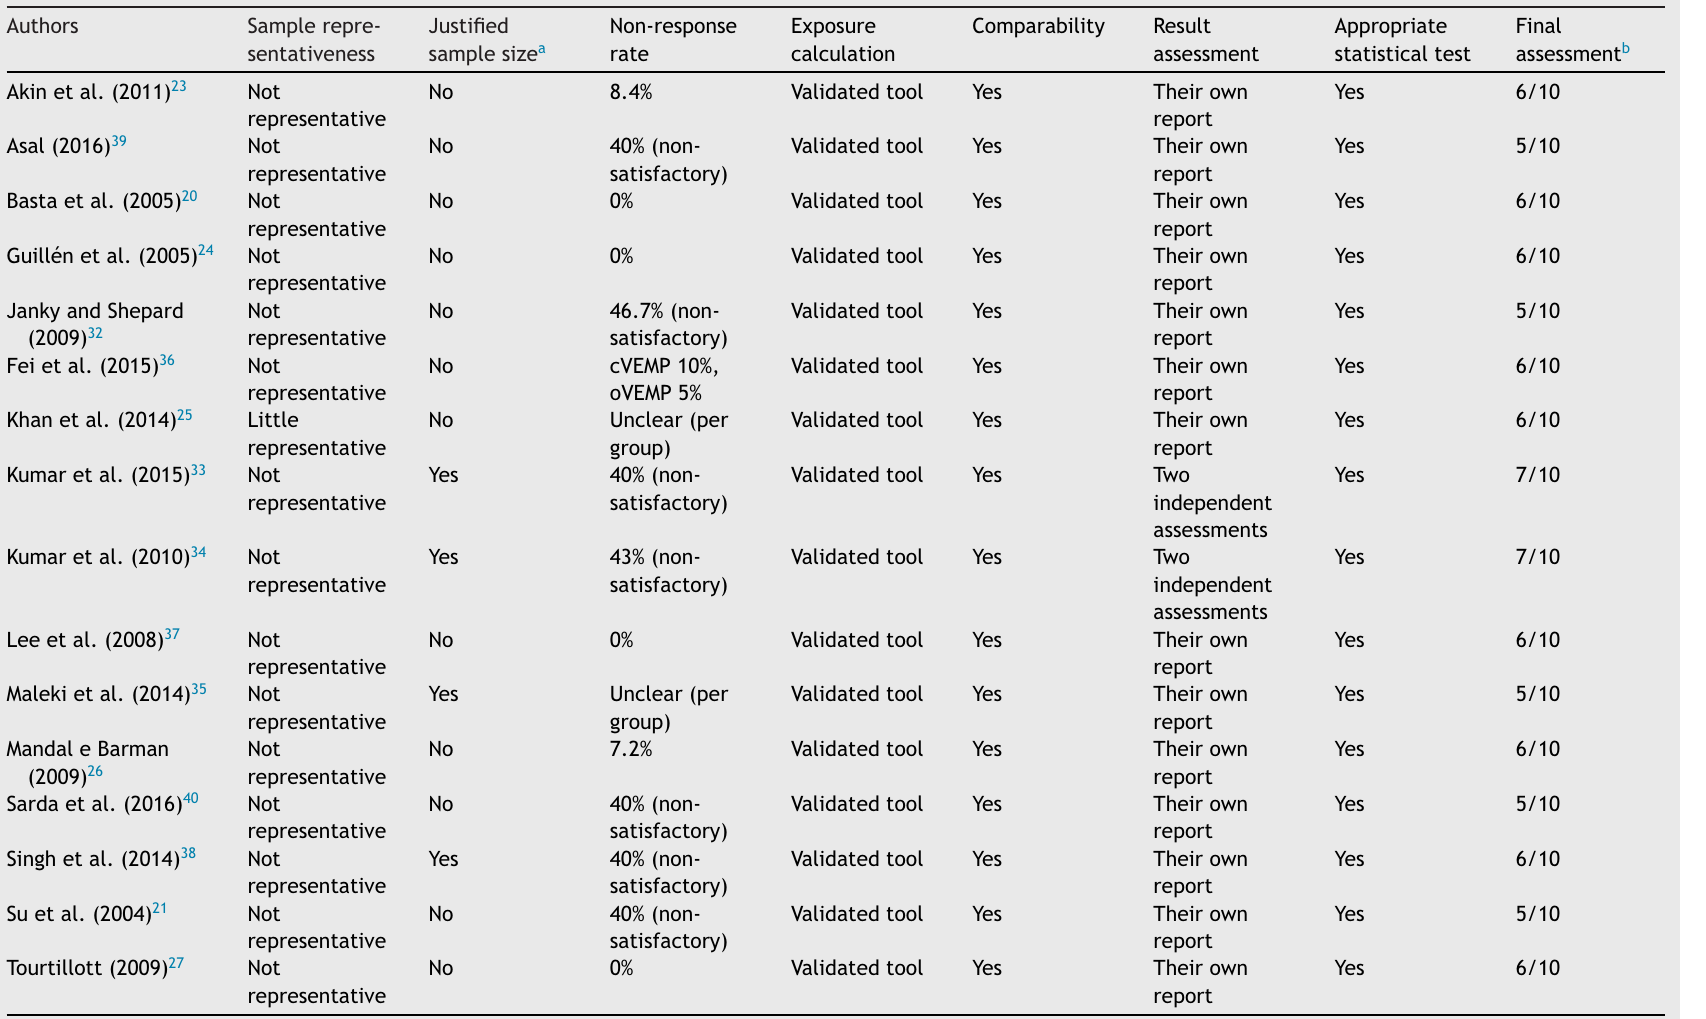
Quality of included articles, according to the ‘‘Newcastle---Ottawa’’ quality assessment